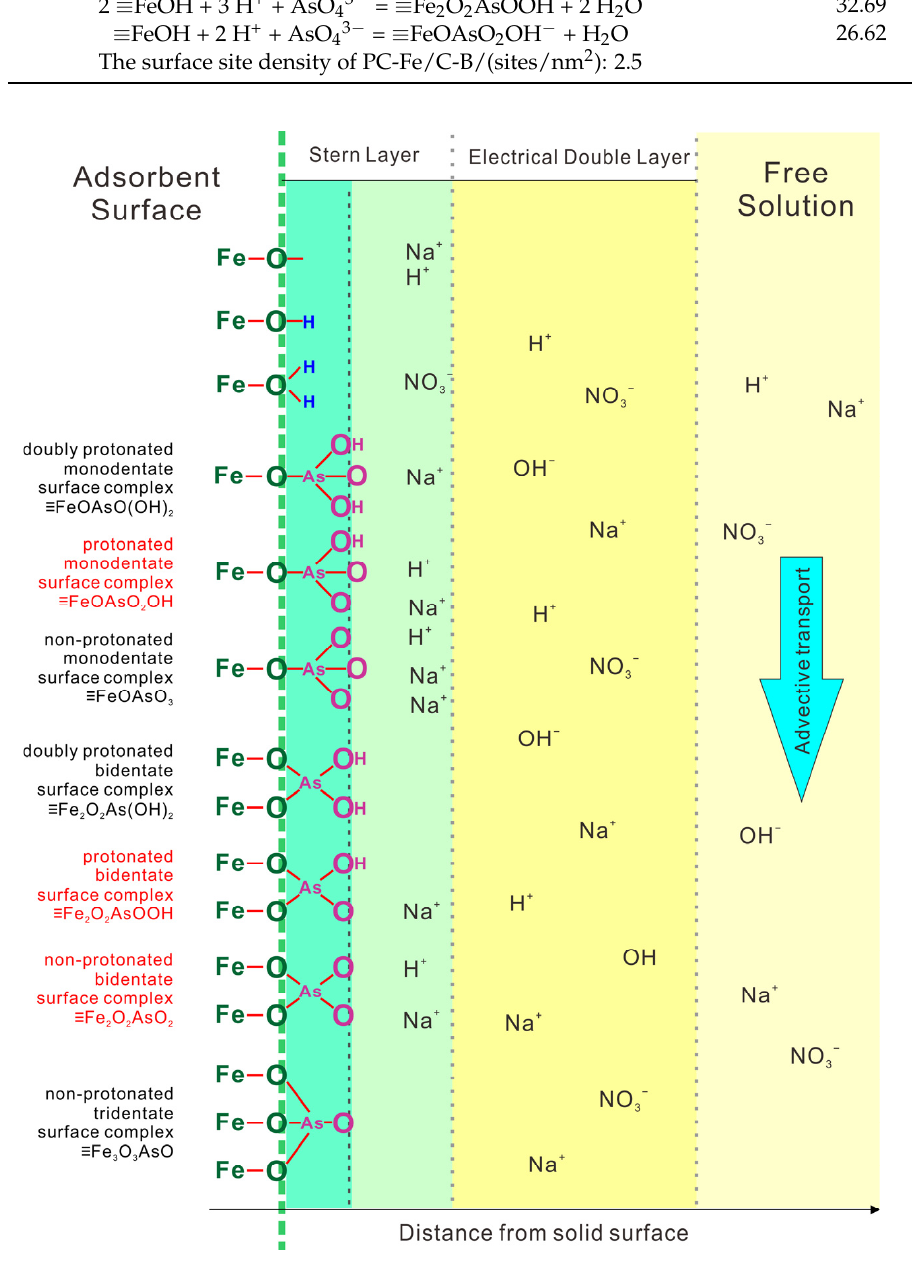
Figure 11. Schematic representation of the parameters of the CD ‐ MUSIC adsorption model.